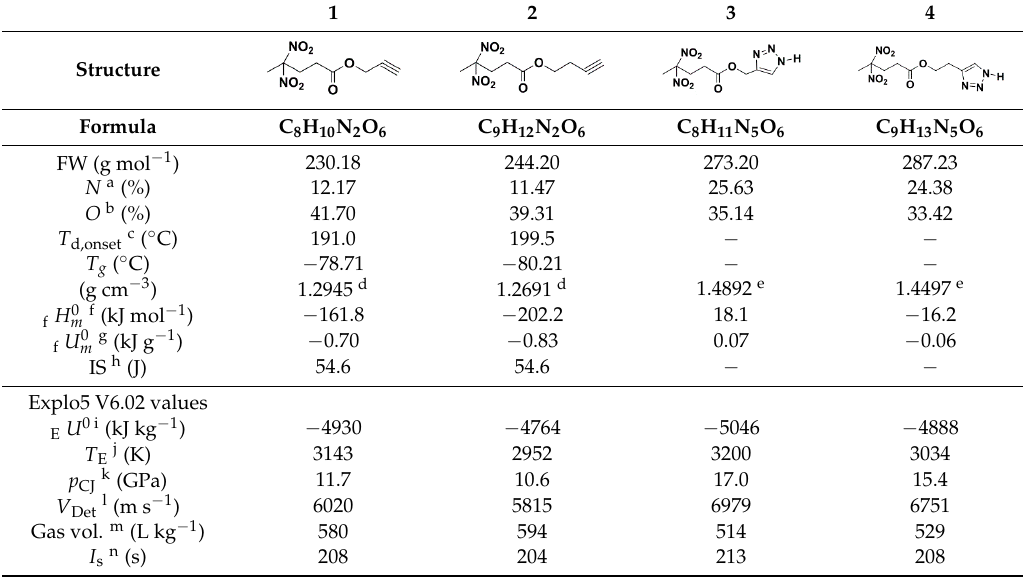
Figure 7. Mechanical properties of the control PGT-based PU and REP/PGT-based PUs. Table 3. Basic properties and detonation parameters of 1 - 4 .